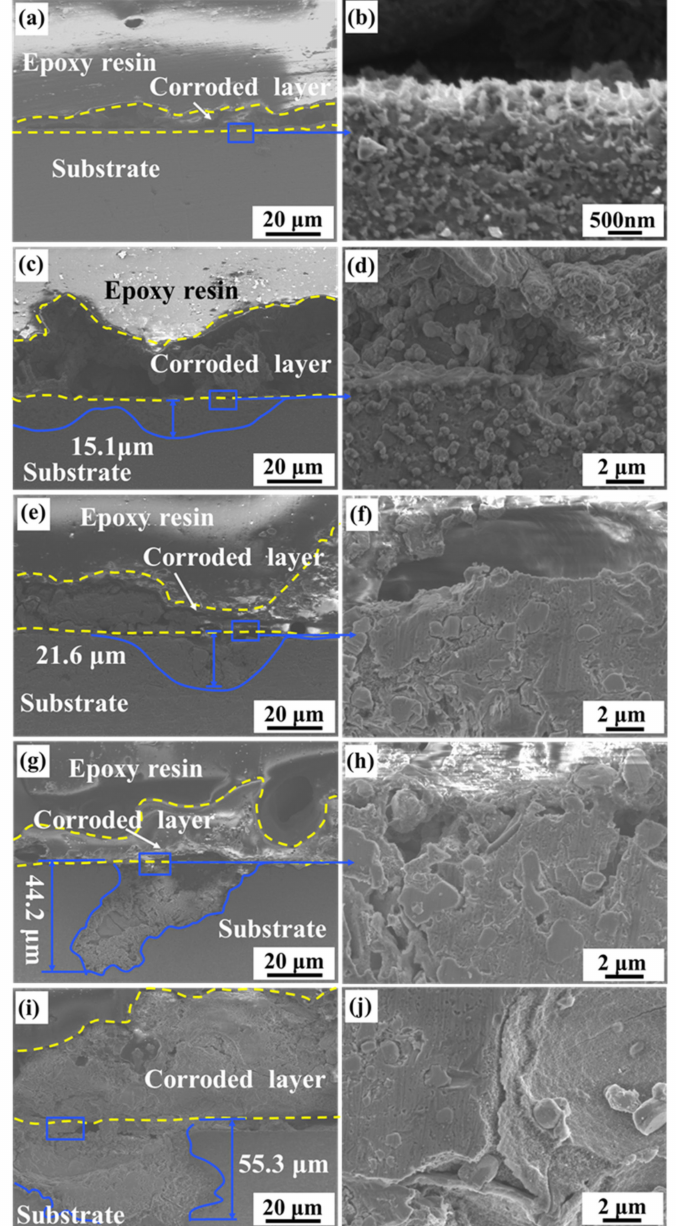
Figure 11. The morphology of the cross section of the alloys after corrosion: ( a , b ) Alloy A, ( c , d ) Alloy B, ( e , f ) Alloy C, ( g , h ) Alloy D, ( i , j ) Alloy